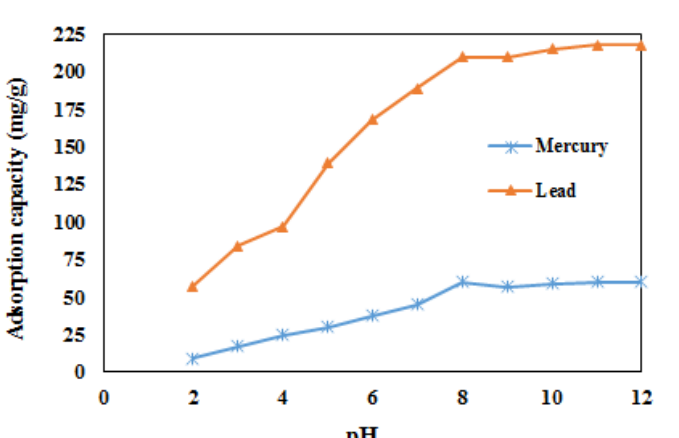
Fig. 4. Effect of solution pH on adsorption capacity (T=298 K, initial concentration for Pb(II) =100 mg/L and for Hg(II)= 20 mg/L).